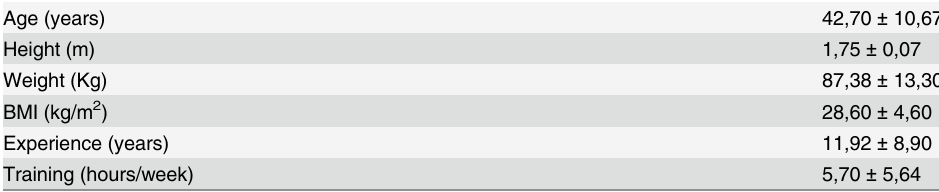
Table 1. Mean ( ± s) values of the participants ’